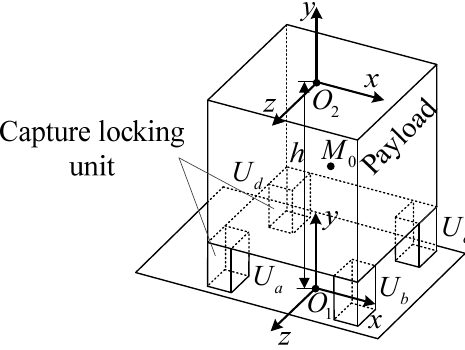
Figure 8. Schematic diagram of the payload coordinate system.